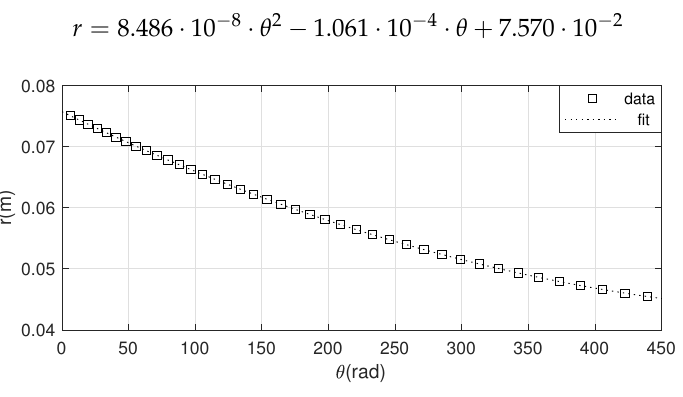
Figure 6. Experimental results for obtaining r ( θ )